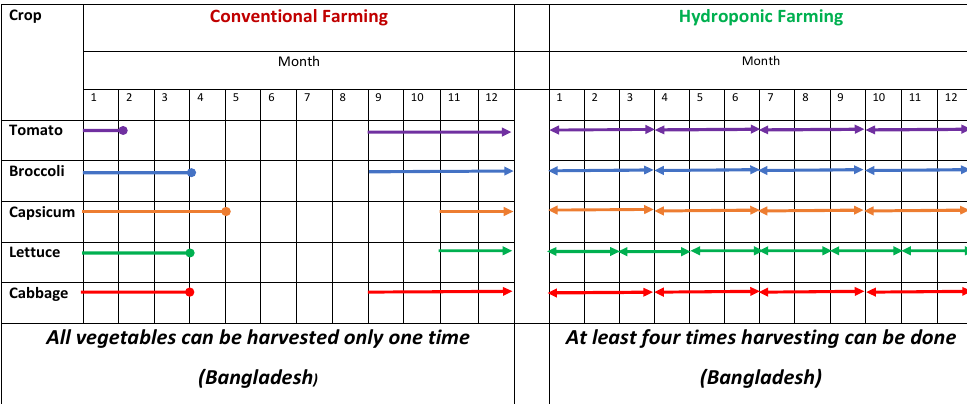
Figure 1. Frequency of harvests of five selected vegetables using hydroponic farming and conven- tional farming.